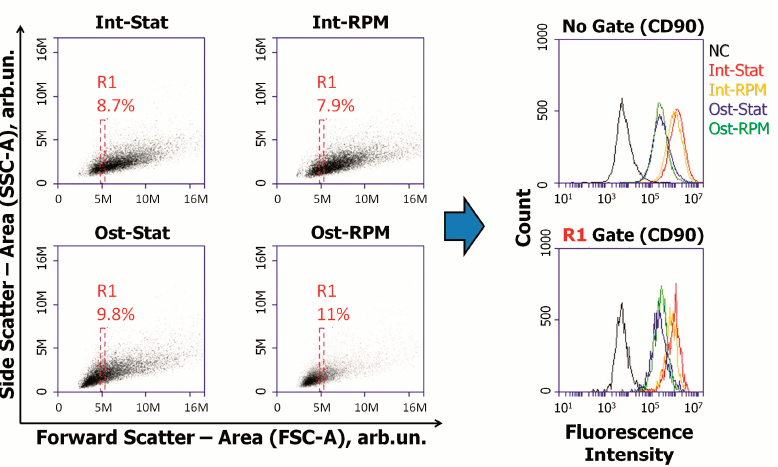
Figure 5. Mean fluorescence intensity of specific antibody to CD90, representative experiment. R1 gate included MSCs of the same size, but differentiated fluorescence remained.